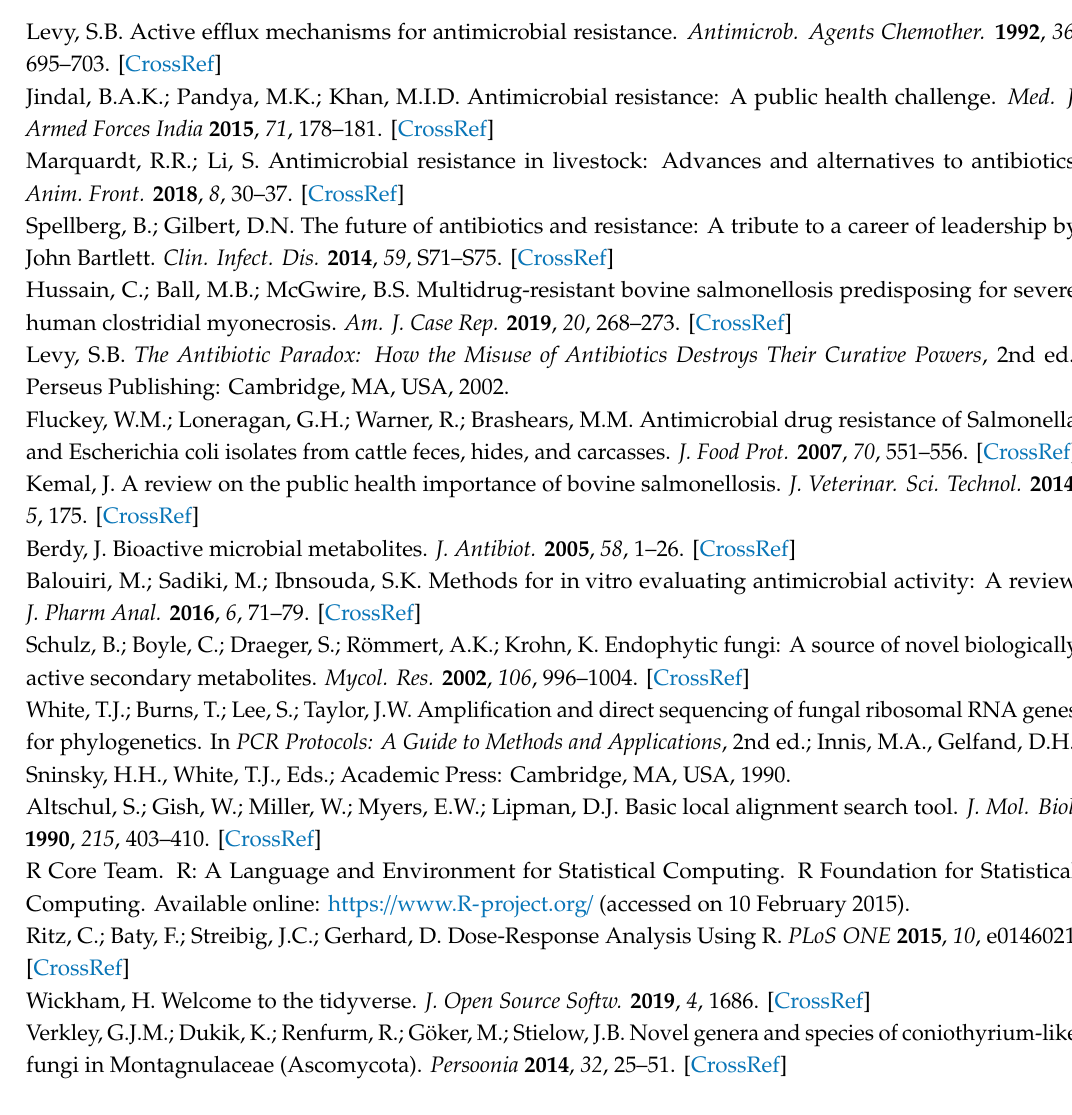
Figure S1. 1 H NMR spectrum of cyclo (L-Pro-L-Phe). Figure S2. LC-MS qTOF spectrum of cyclo (L-Pro-L-Phe). Figure S3. High resolution electrospray mass spectrum of cyclo (L-Pro-L-Phe). Figure S4. Paraphaeosphaeria sporulosa CREA-CI grown on potato dextrose agar (A); (B) and (C), microscopic pictures of conidia. Figure S5. Inhibition halos on Petri plates of Paraphaeosphaeria sporulosa CREA-CI extract on Salmonella enterica strains (A); inhibition halos on Petri plates of cyclo (L-Pro-L-Phe) on Salmonella enterica strains (B—right